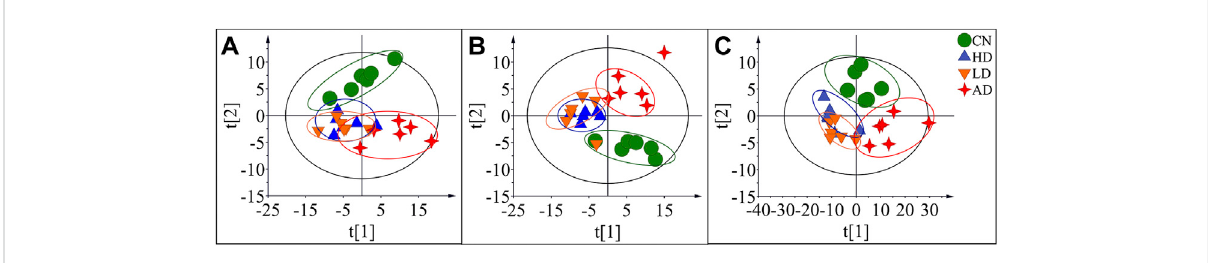
FIGURE 7 PLS-DA score plots of the serum samples from CN group, AD group, LD group, and HD group in positive mode of LC-QTOF/MS (A) , negative mode of LC-QTOF/MS (B) , and in GC-MS (C) .